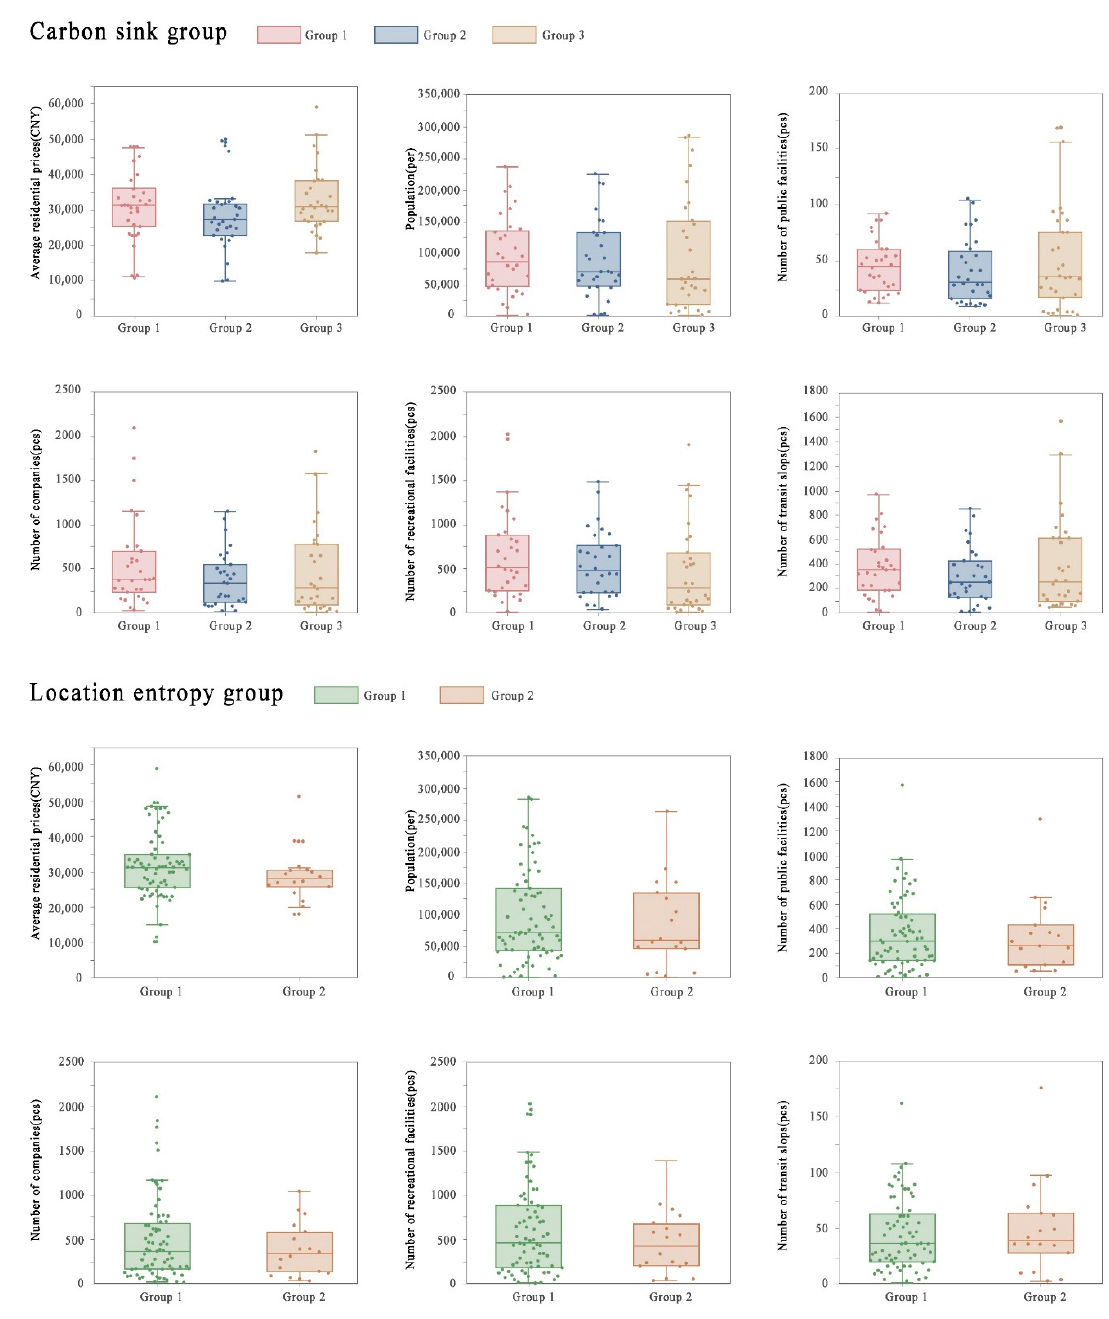
Figure 5. Box plot of Socioeconomic activities.